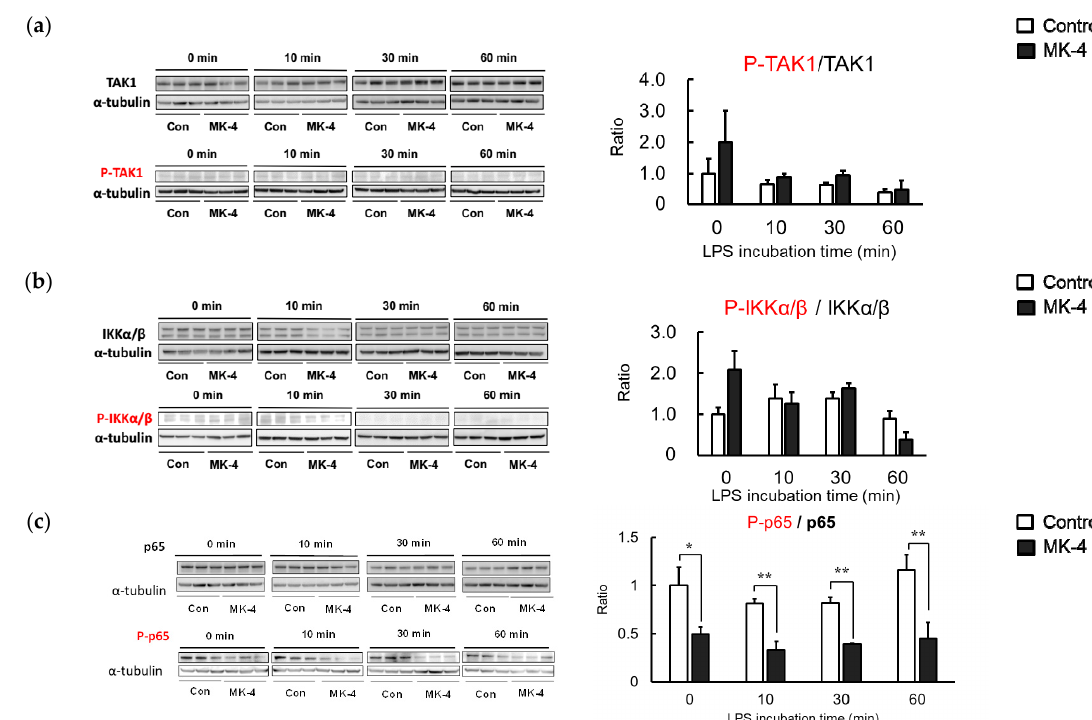
Figure 5. Menaquinone-4 (MK-4) administration reduces phosphorylation of the NF- κ B p65 subunit. MG6 cells were treated with MK-4 (10 µ M) for 24 h and subsequently exposed to LPS (1 ng / mL). Whole-cell lysates were prepared after 0, 10, 30, and 60 min and analyzed by Western blotting. ( a – c ) The protein bands and the ratio of phosphorylated protein was compared to total levels for TAK1 ( a ), IKK α / β ( b ), and p65 ( c ). Data are presented as the mean ± S.E.M, n = 3, normalized to α -tubulin levels, and expressed as the fold-change relative to control cell values (con: cells not treated with MK-4 at 0 min post-LPS stimulation). Values were significantly di ff erent from those of the control at * p < 0.05 and ** p < 0.01.